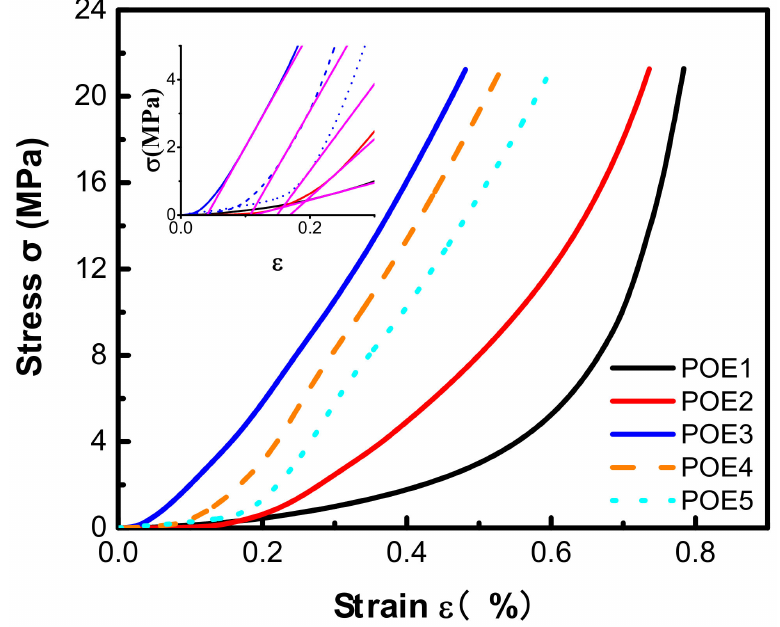
Figure 15. Compressive stress-strain curves of different